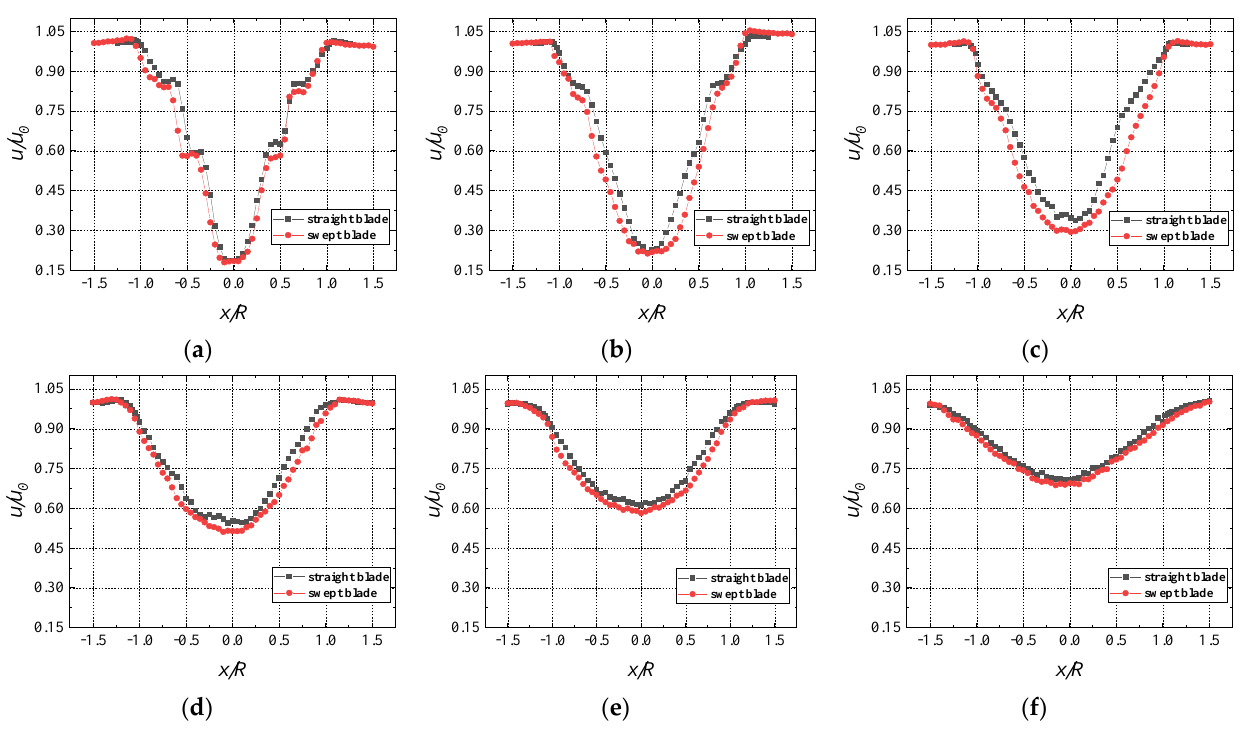
Figure 12. Streamwise time-averaged velocity distribution at a yaw angle of 0° when λ = 4.67 . ( a ) 0.5D; ( b ) 1D; ( c ) 2D; ( d ) 3D; ( e ) 5D; ( f ) 8D.